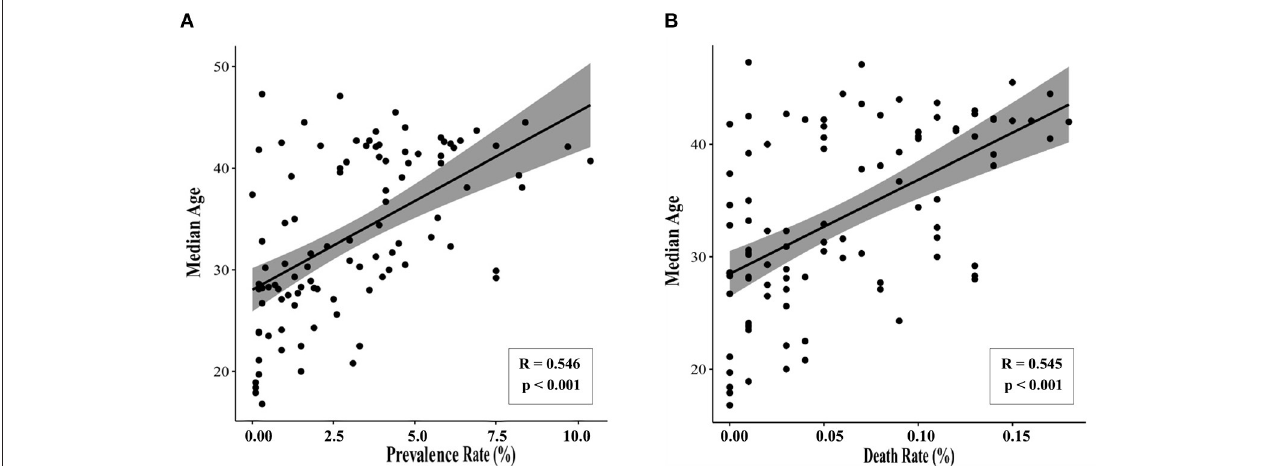
FIGURE 2 | Median age correlates with SARS-CoV-2 prevalence and death rate. Data were collected for the 100 countries with the highest prevalence of SARS-CoV-2 (accessed February 10, 2021). Statistically significant correlations were observed between median age and (A) prevalence of SARS-CoV-2 (Pearson r =